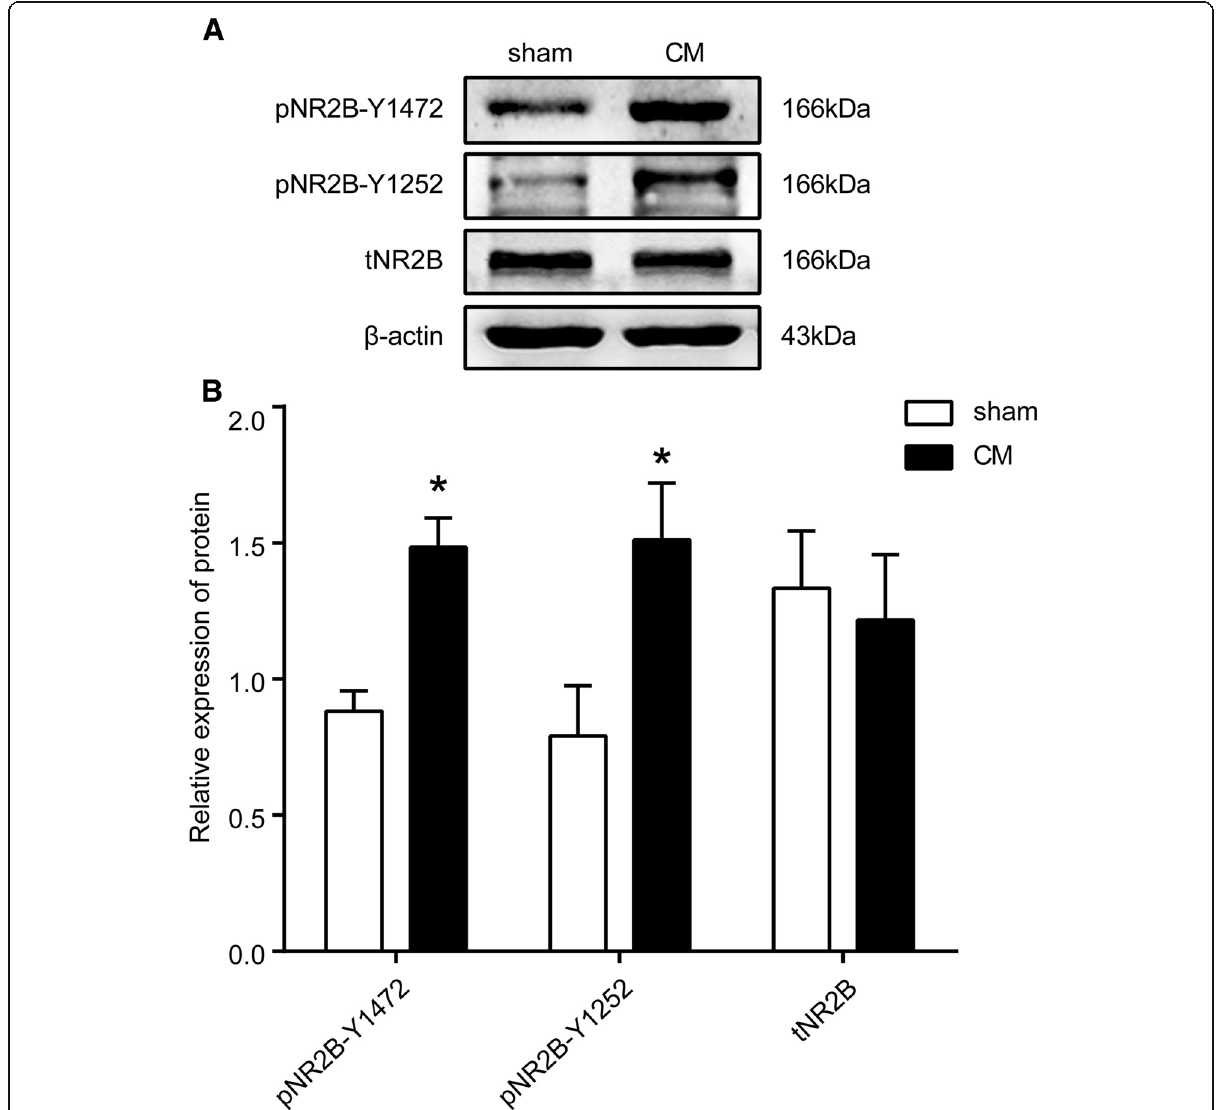
Fig. 2 Expression of NR2B and tyrosine-phosphorylated NR2B in the TNC of CM rats. a Representative western blots of NR2B-Y1472, NR2B-Y1252 and tNR2B. b The phosphorylation of the NR2B receptor subunit at tyrosine 1472 and 1252 was significantly increased in the CM group compared with the sham group. However, the expression of tNR2B in the CM group was indistinguishable from that in the sham group ( n = 6 in each group, * P <